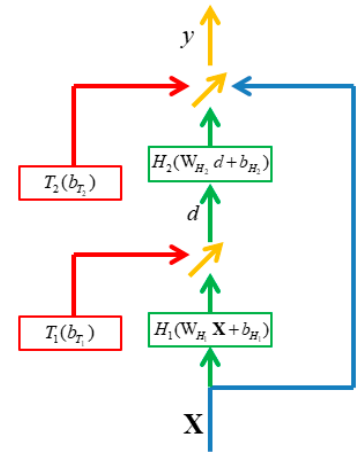
Figure 3. Illustration of DHNs.